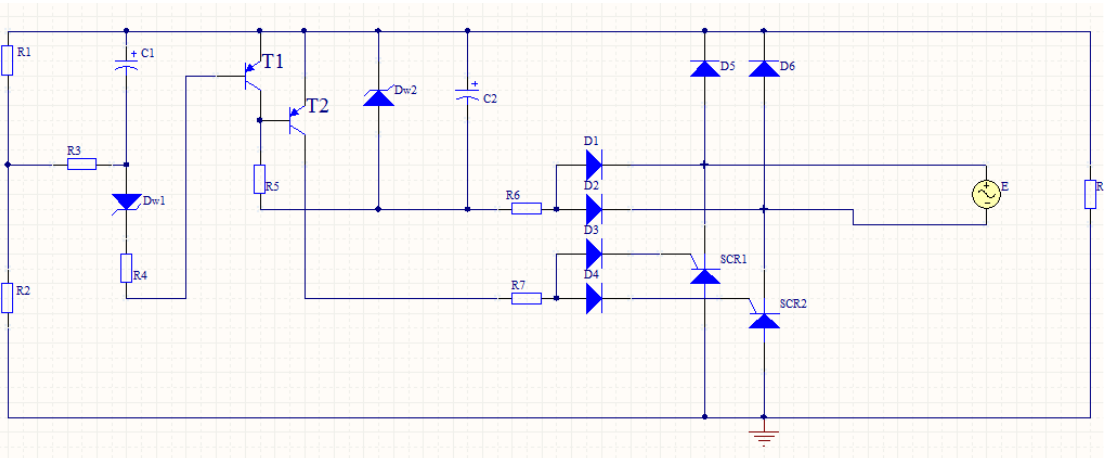
Figure 4. Schematic of voltage-stabilizing circuit. RL is rheostat; R1, R2, R3, R4, R5, R6, R7 are the resistance; C1, C2 are the capacitance; D1, D2, D3, D4 are the diodes; D5, D6 are the rectifiers; Dw1, Dw2 are stabile tubes; T1, T2 are triodes; SCR1, SCR2 are silicon controlled rectifiers.